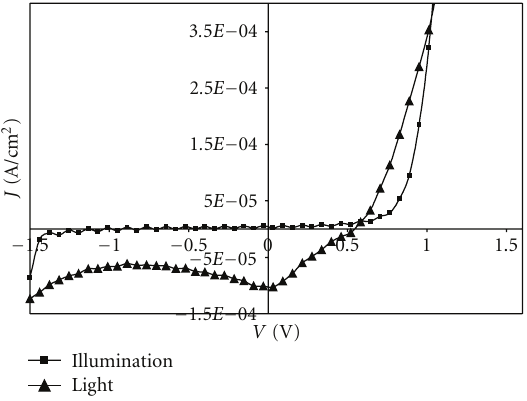
Figure 5: Current-voltage characteristic curves of FTO/CuInS 2 / ZnO/FTO heterojunction under dark and